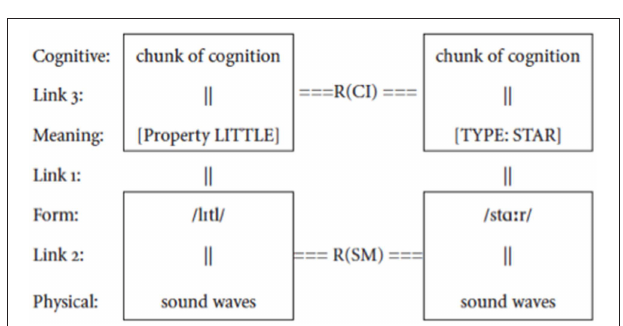
FIGURE 2 | The structure of a combinatorial sign. A syntactic combination of words such as little and star is realized by a combinatorial sign which operates simultaneously on their meanings, creating a relation R(CI) at the conceptual-intentional level, and on their forms, creating a relation R(SM) at the sensory-motor